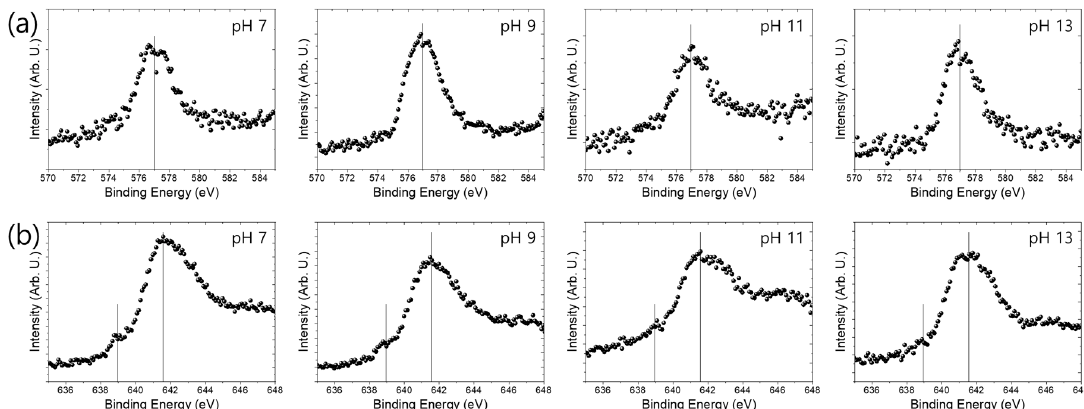
Figure 4. ( a ) Optical images of S400 and Fe-based shape memory alloy immersed in deionized water for a day with various pH values, adjusted by CaO. XPS core-level spectra of Fe 2p3/2 of ( b ) FSMA and ( c ) S400 immersed in deionized water for a day with various pH values, adjusted by CaO.